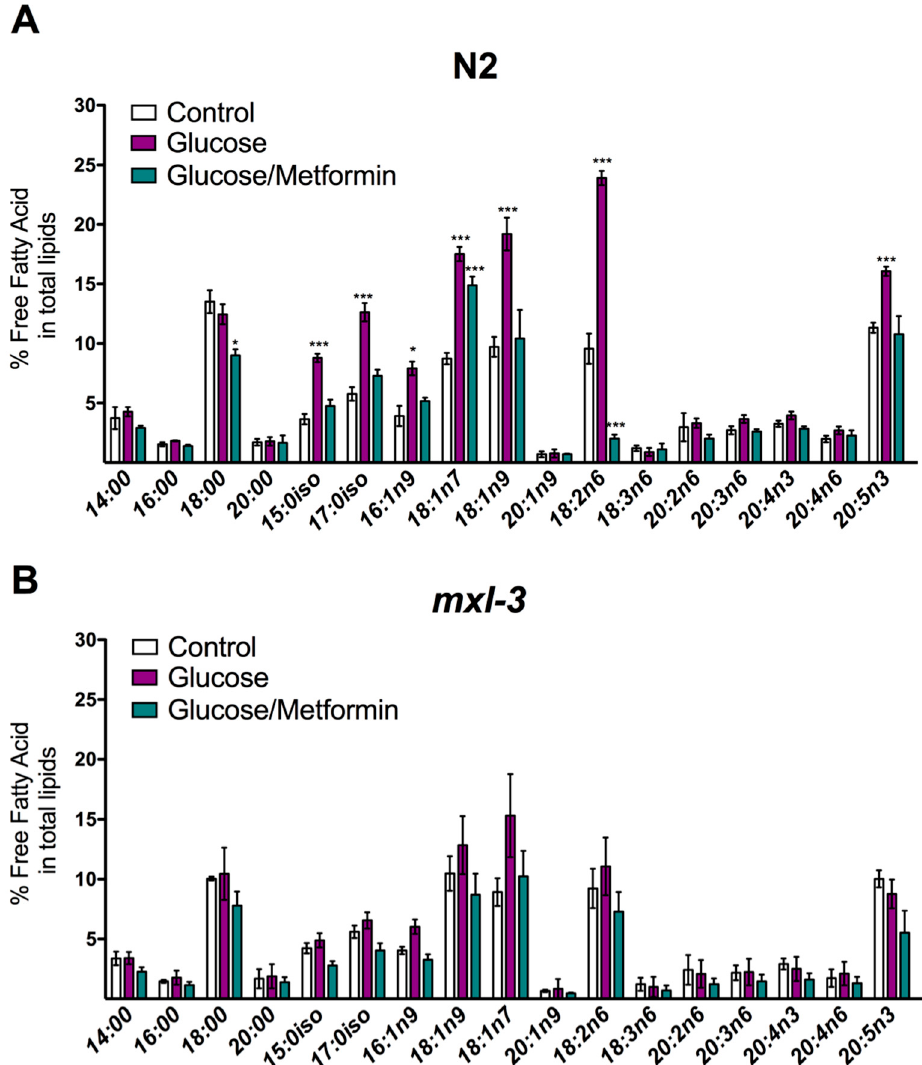
Figure A1. The striking lipid profile shift after glucose and metformin exposure is controlled by MXL-3. A subset of 17 fatty acids is shown in the N2 and mxl-3 mutant strains treated with high glucose and high glucose plus metformin. ( A ) FFAs that increased due to glucose exposure showed a clear tendency to return to the levels of the control group in the presence of metformin. ( B ) FFAs are unable to change in the mxl-3 mutant due to glucose or metformin. Graphs depict the mean ± SEM of three independent experiments; * p < 0.05, *** p < 0.001 vs. fatty acids in the control group, one-way ANOVA with Bonferroni’s post hoc test using GraphPad Prism.